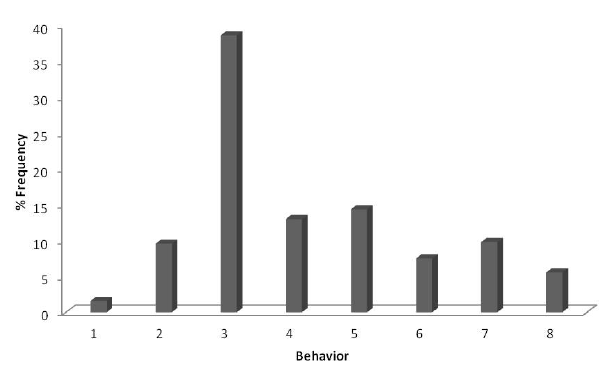
Fig 2 . Percentage of each behavioral act performed by Atta sexdens rubropilosa during preparation of the bait substrate and its incor- poration into the fungus garden. 1: Transporting the pellet to the surface of the fungus garden; 2: holding the pellet; 3: licking the surface; 4: pellet fragmentation; 5: pressing the pellet fragment; 6: deposition of fecal fluid; 7: incorporation into the fungus garden; 8: deposition of hyphae on the incorporated